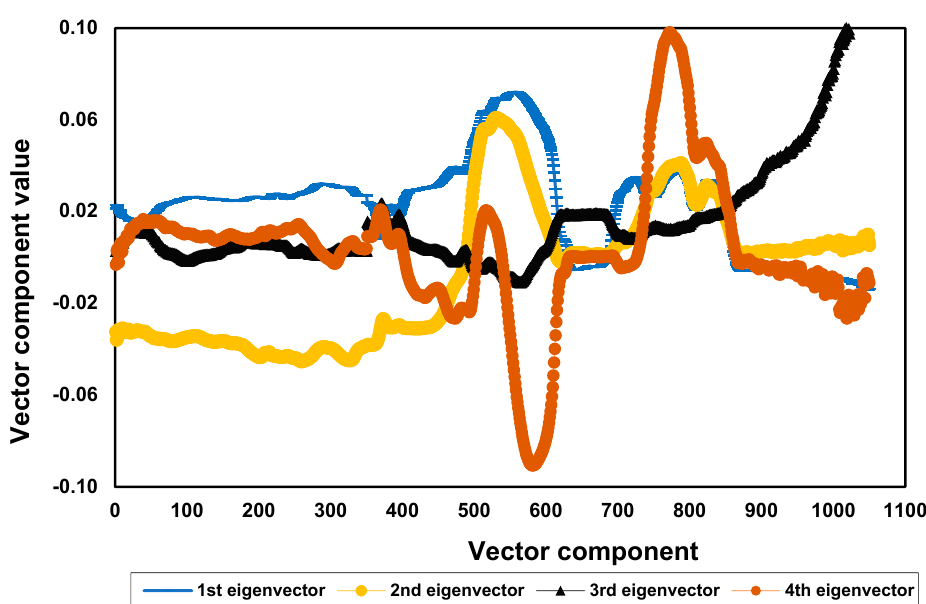
Figure 4. The four eigenvectors of the covariance matrix of NIR spectral measurement fluctuations evaluated for solutions containing 20 vol% xylene and 80 vol% toluene at 30 °C and stirring velocity of 250 rpm.